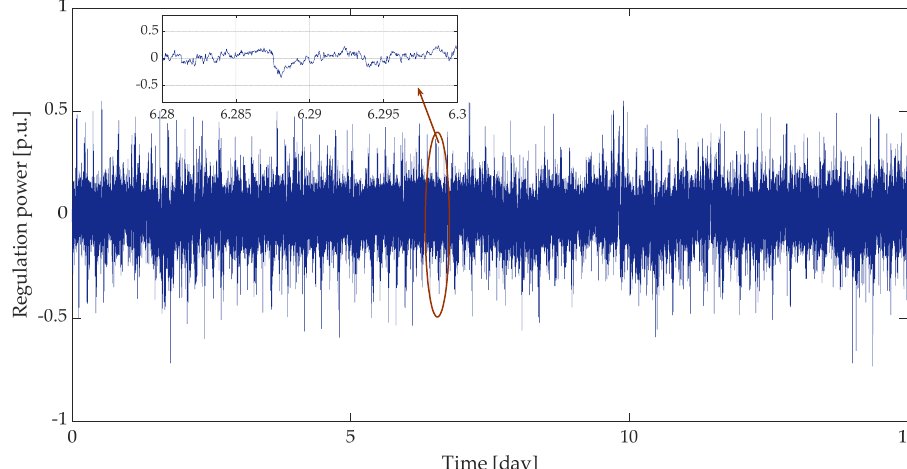
Figure 13. Regulation power in Case 1.